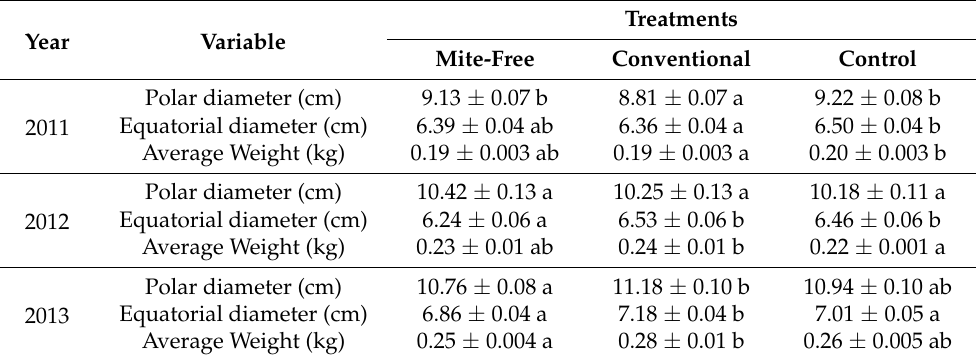
Table 7. Mean ( ± SE) average weight (kg), polar and equatorial diameter (cm) for avocado trees subjected to three treatments over a period of three years in Tenerife. SE followed by letters compares differences between treatments for each variable and year, and when the letters are different, the difference is significant according to Tukey’s HSD multiple range test: p <